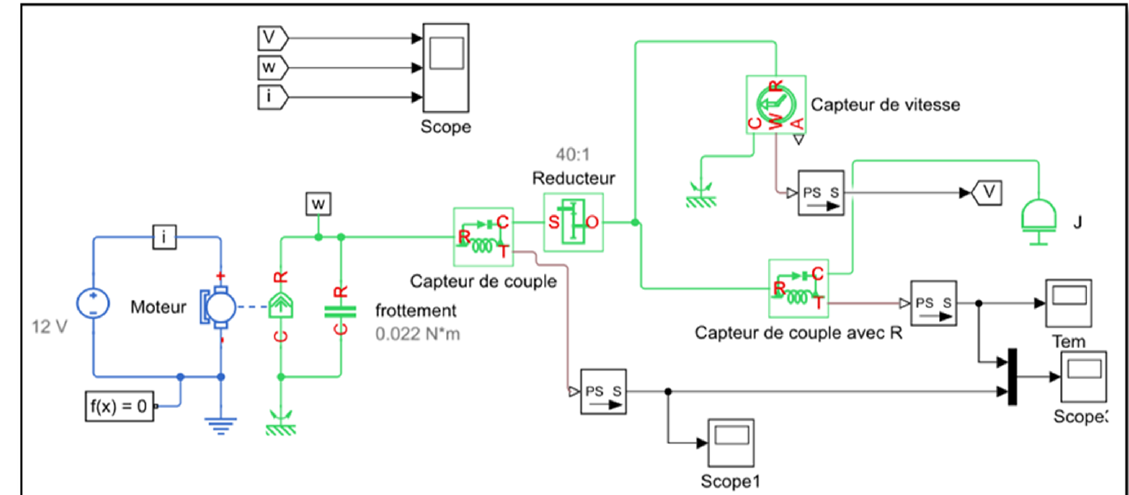
Figure 9. Block model of a voltage ‐ fed motor using SimScape’s Simulink.